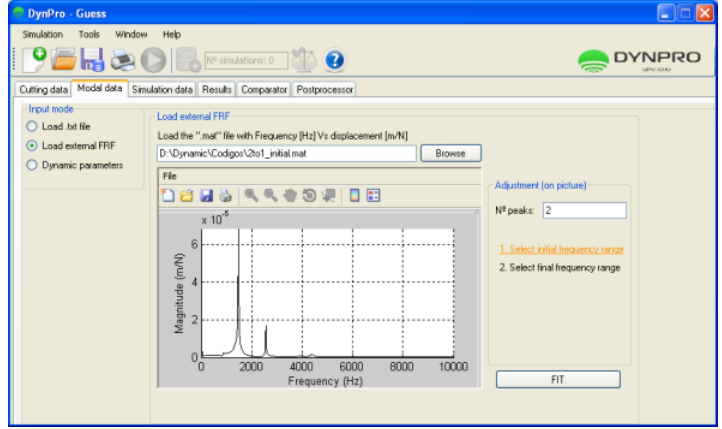
Figure 5. Frequency Response Function (FRF) analysis.